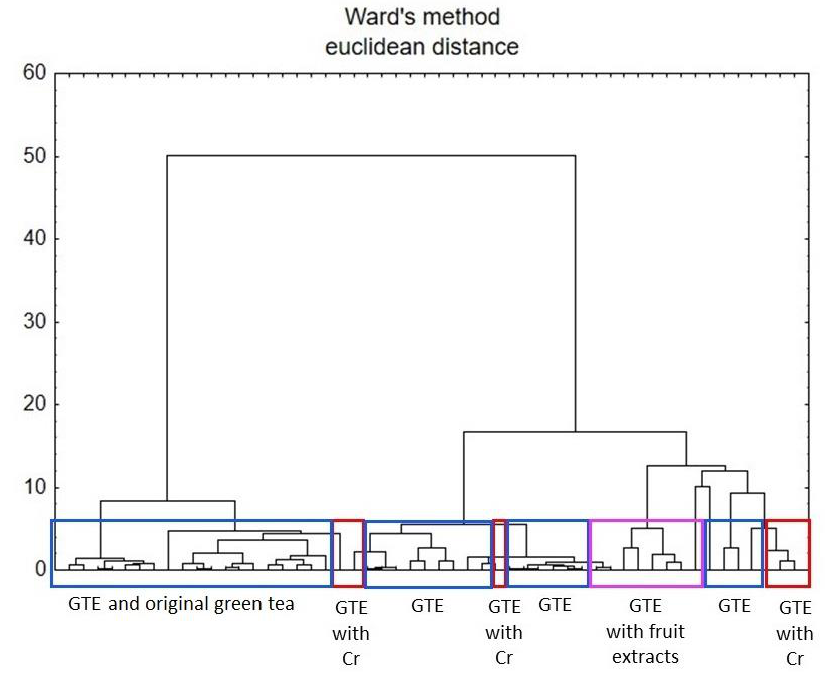
13 of 25 Figure 2. ( a ) Scatterplot of object samples for two factors of the analysed dietary supplements